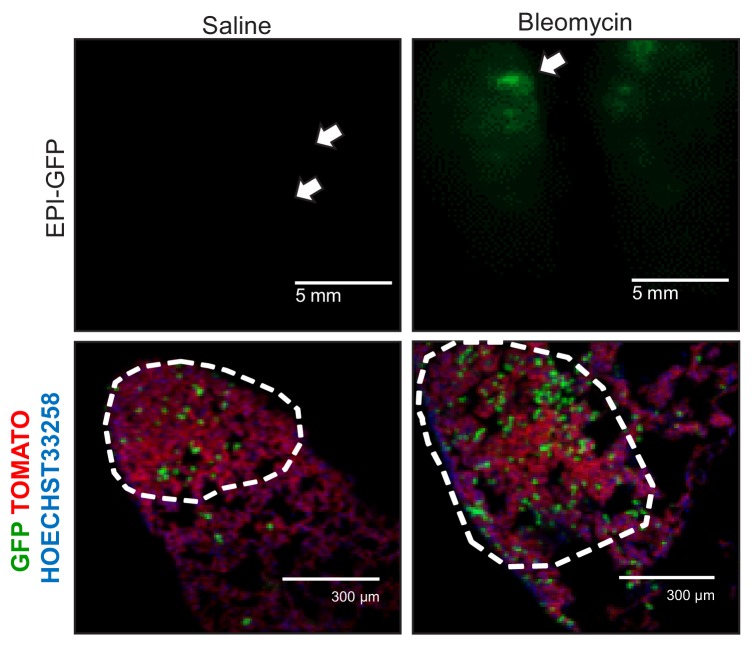
Alveolar type II cell ablation using bleomycin pre-treatment increases airway-labeled cells in urethane-induced lung tumors: representative images.Representative epifluorescence (top) and merged fluorescent microscopy (bottom) images of tumor-bearing lungs and lung tumors of six-week-old GFP;CCSP.CRE mice that received intratracheal saline or 0.08 units bleomycin (n = 6/group), were allowed to recover for one month, and subsequently received ten weekly intraperitoneal injections of 1 g/Kg urethane to be sacrificed six months after the first urethane injection. Arrows and dashed outlines indicate lung tumors.